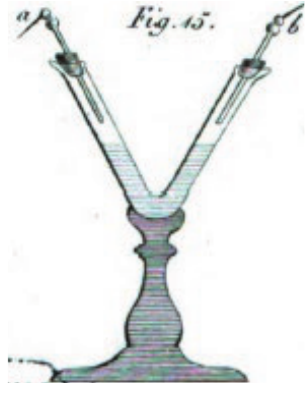
Figure 3. The V-shaped glass tube with side pieces of 2 German inches (i.e. about 3 cm) in length was first filled halfway with pure concentrated sulphuric acid. The acid was then overlaid with dis- tilled water, into which the two poles a and b were dipped. The poles, made from gold, were connected with the voltaic pile. Taken from ref. [26] , after p. 326, Taf. 1, Fig.